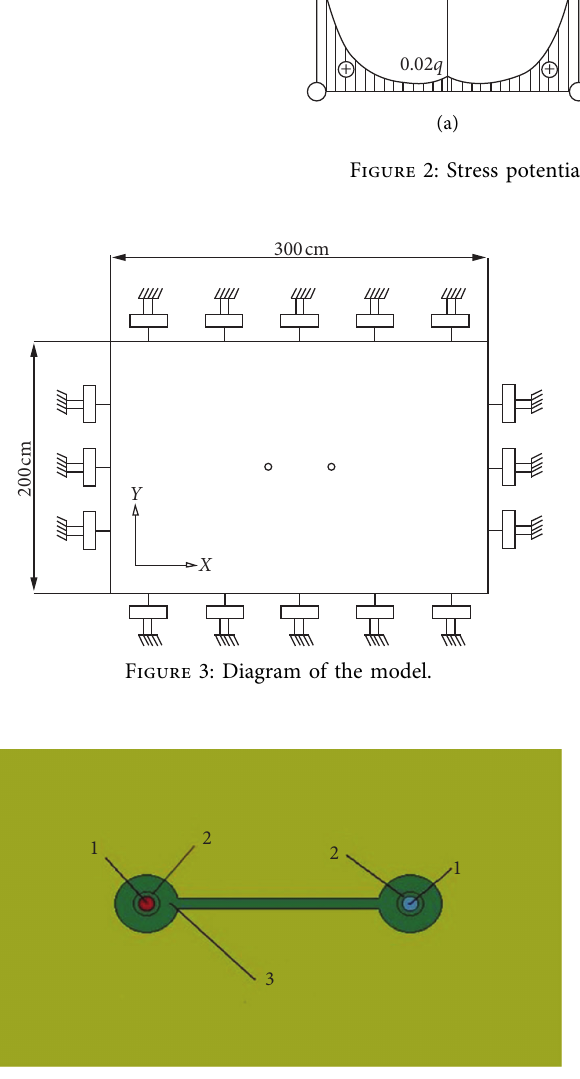
Figure 4: Air domain.1: explosives; 2: air in the blasthole; 3: the air domain overlapped with the rock.